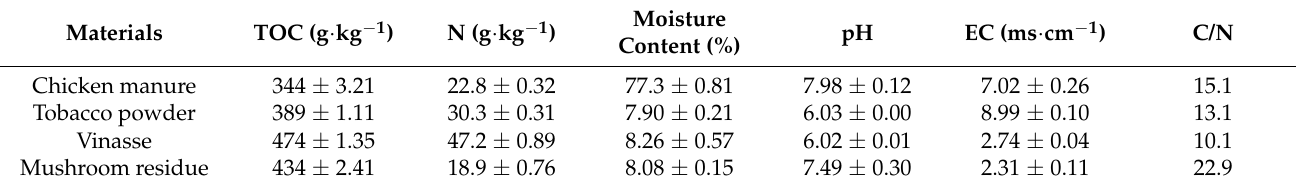
Table 1. General characteristics of the initial composting materials.